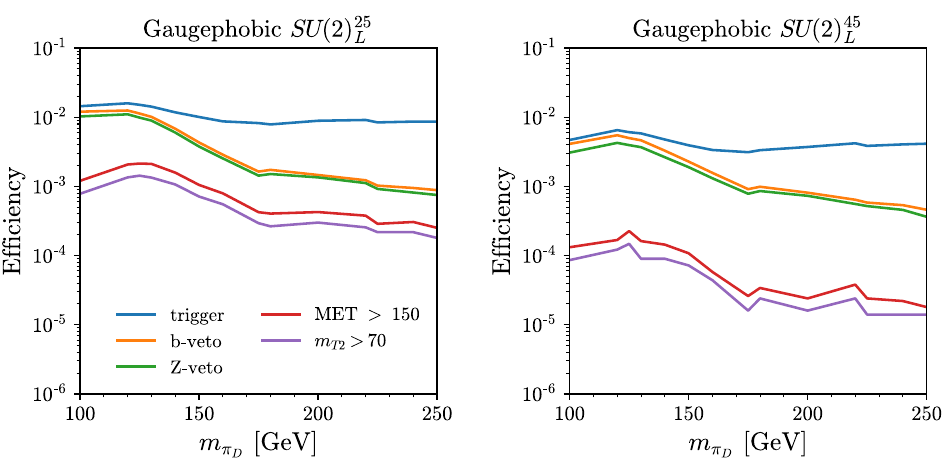
Figure 7 . Cut flow for the search for hadronically decaying taus, optimized for electroweak produc- tion of supersymmetric particles [147]. The efficiency is much larger for the η = 0 . 25 benchmarks than the η = 0 . 45 models because the larger ρ efficiency is offset by the decrease in resonant production cross